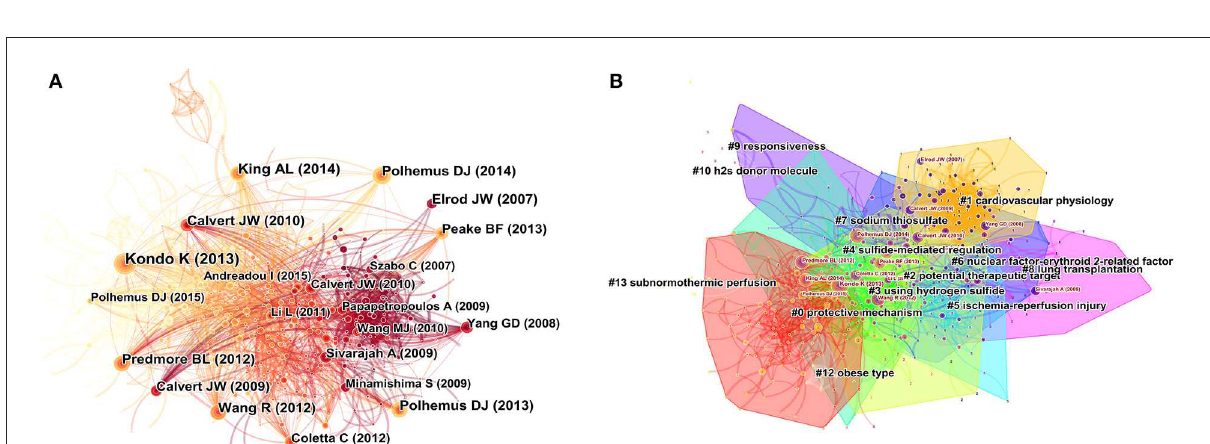
FIGURE4 Analysis of references to hydrogen sulfide in heart preservation research. (A) Network map of co-cited references. (B) Network map of co-cited